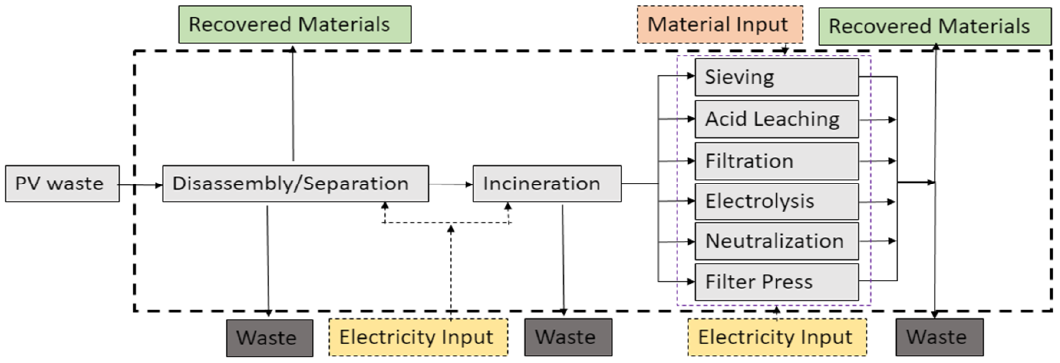
Figure 1. Simplified PV recycling process modeled from Latunussa et al., 2016 [20].